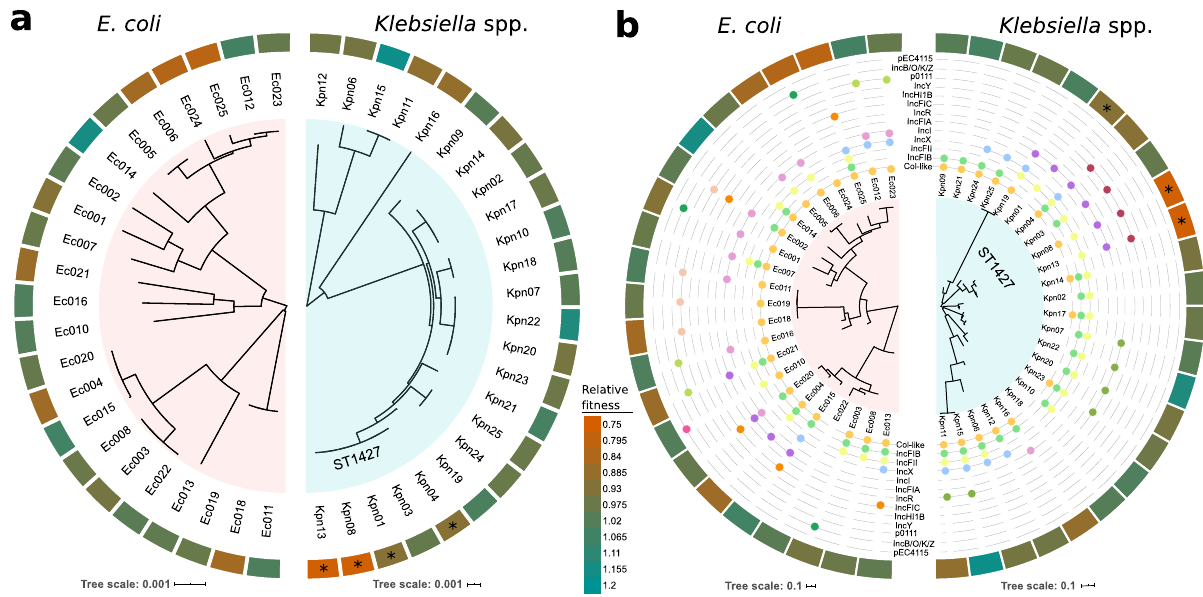
Fig. 4 Fitness effects of pOXA-48_K8 across bacterial genome content. An association was found between pOXA-48_K8 fi tness effects and bacterial host genomic content for four K. pneumoniae ST1427 isolates. a Core genome relationships among E. coli (left) and Klebsiella spp. (right). Tree construction is based on polymorphisms in the core genome. The outer circle indicates the relative fi tness of pOXA-48-carrying bacterial hosts (see legend for colour code; red indicates fi tness costs and green indicates fi tness bene fi ts associated with pOXA-48_K8 carriage). Asterisks denote clones with a phylogenetic signal associated with plasmid fi tness effects (LIPA, P < 0.05). b Accessory genome relationships among E. coli (left) and Klebsiella spp. (right) isolates. This tree is a gene content tree constructed based on the distance matrix of the accessory gene network of each group. The outermost circle indicates relative fi tness as in a . The intermediate circles indicate presence/absence of plasmids belonging to the different plasmid families named in the fi gure. Note that only two isolates do not carry any plasmids. Asterisks denote clones with a signi fi cant phylogenetic signal associating accessory genome composition with pOXA-48 fi tness effects (LIPA, P <